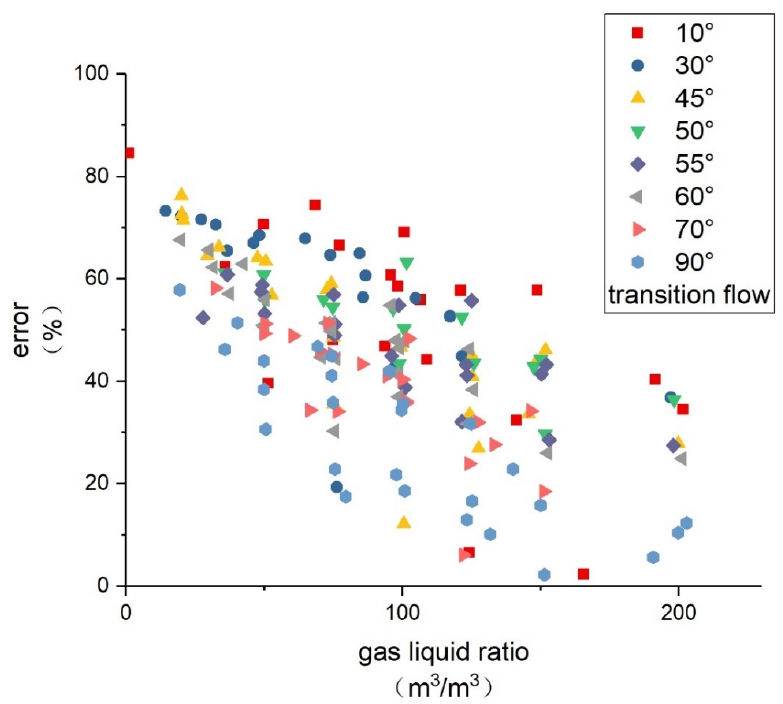
Figure 16. The error between calculated values and actual values in transition flow.